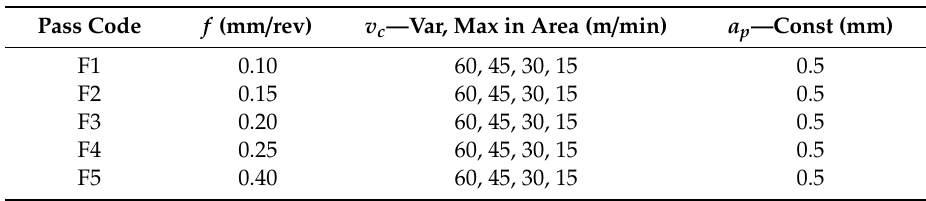
Table 3. Cutting Table 3. Cutting parameters.